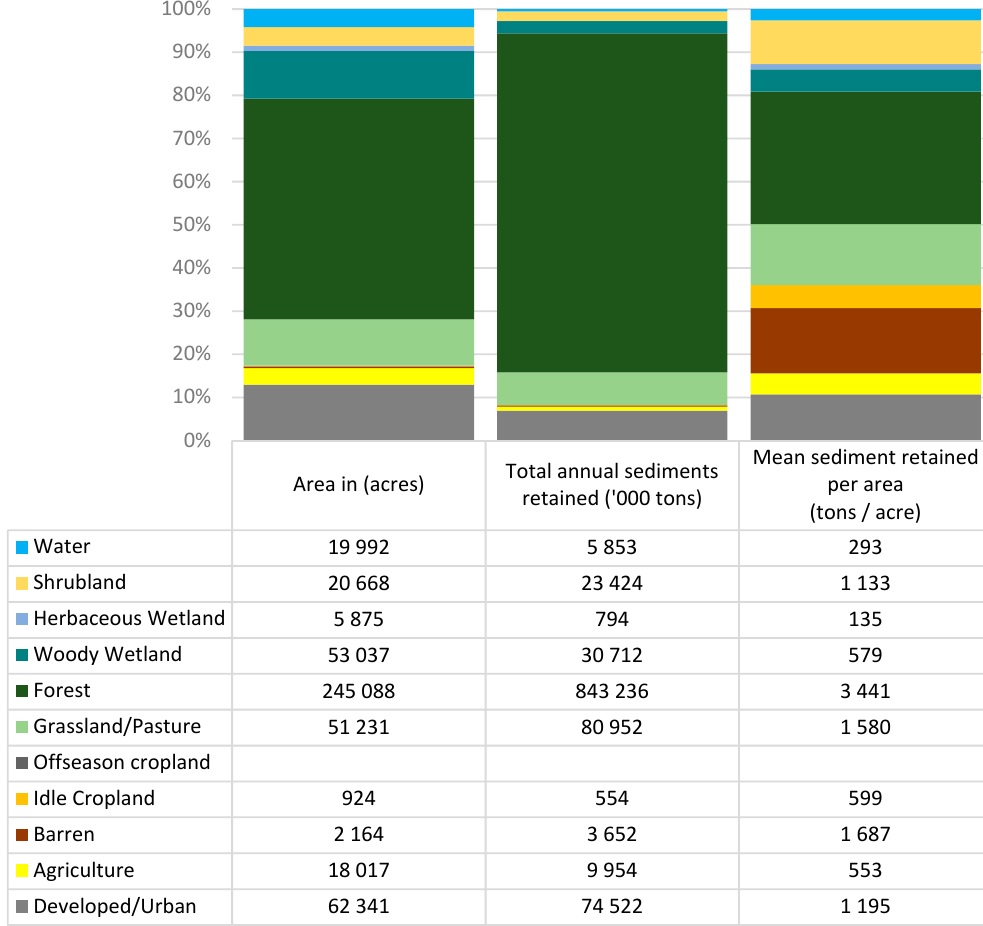
Figure 6. The annual total sediments retained per land cover in SRBN showed that the forest land provide the most Scheme 6. Results indicated that forest land cover has the highest retention capacity with a mean of 3400 tons of sediments per acre annually. Furthermore, the overall mean sediments retained per acre of other vegetated areas amounted to 3980 tons per acre, while the non-vegetated areas amounted to 3480 tons per acre.